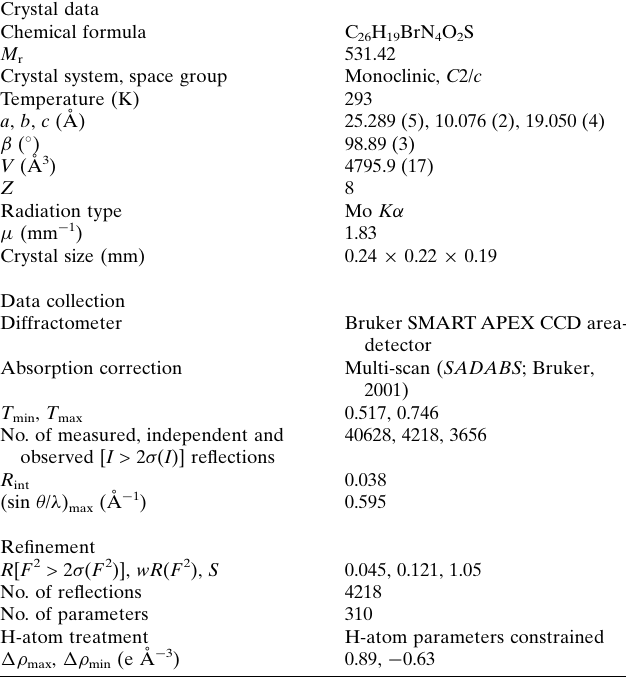
Table 2 Experimental details. Crystal data Chemical